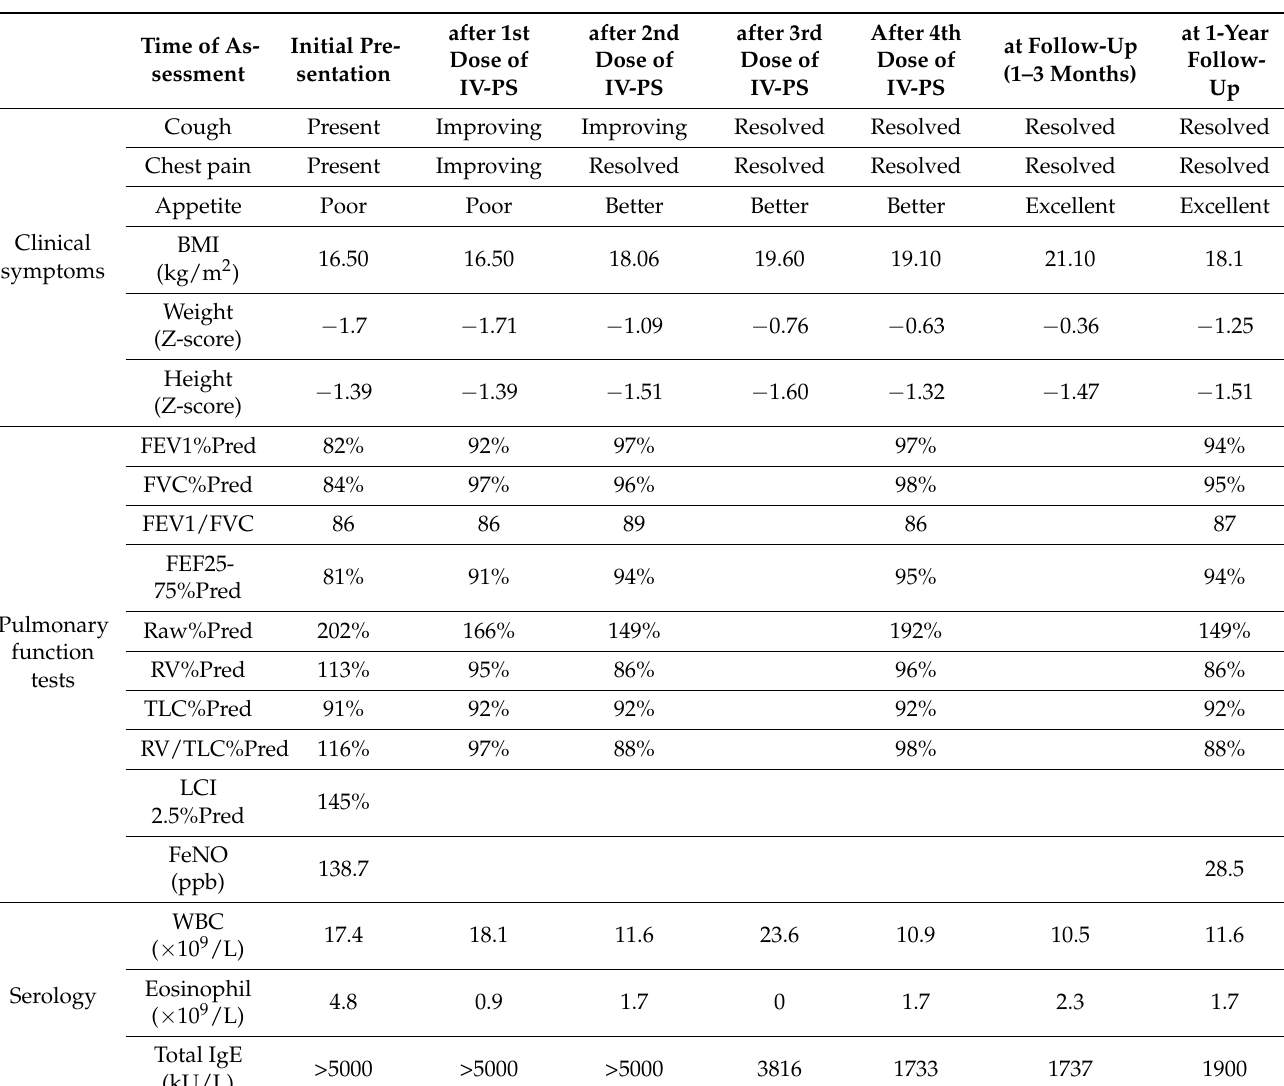
Table 1. The patient’s Clinical Symptoms, Pulmonary Function Tests, and Serological